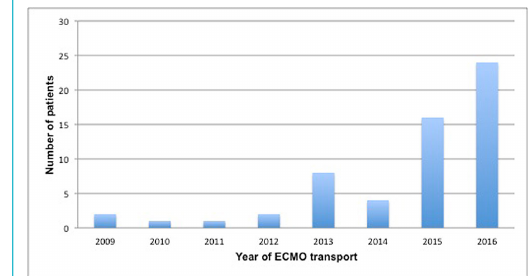
Figure 1: Number of patients on extracorporeal membrane oxy- genation (ECMO) transported by year. The graph shows an in- crease in the number of ECMO transports over the duration of the study, with an exponential increase in 2015 and 2016. One patient was excluded due to international repatriation following ECMO im- plantation in our institution and two due to incomplete medical records from the years 2009 and 2010.